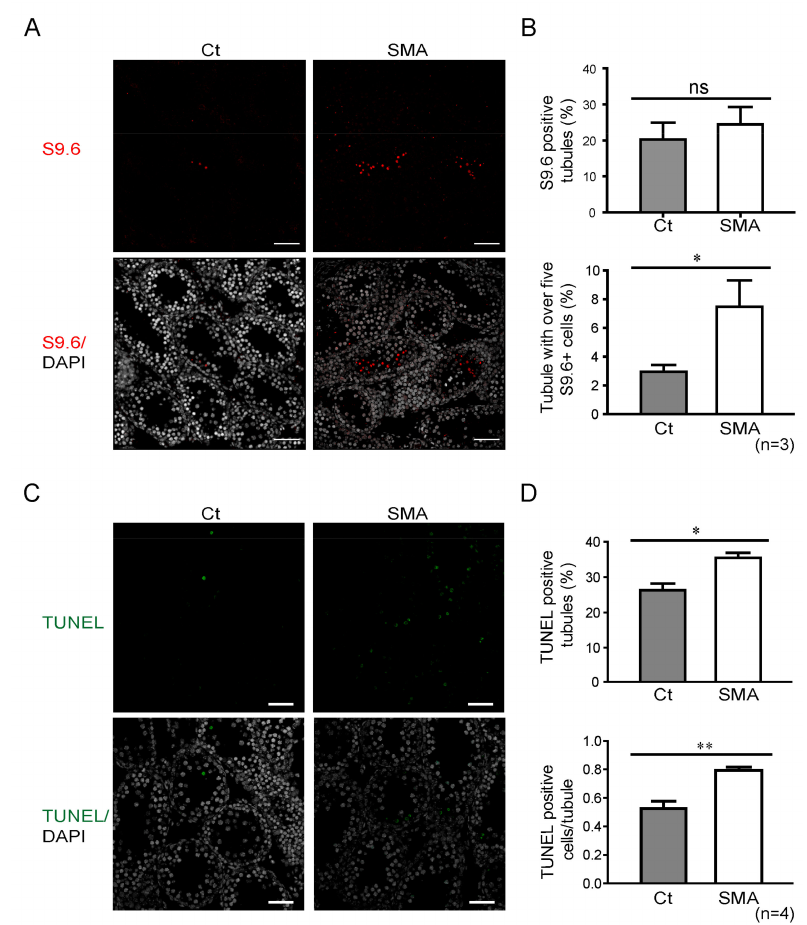
Figure 4. Detection of RNA:DNA hybrid structure in SMA-like mice. ( A ) Staining result of the RNA:DNA hybrid structure, R-loop, by the detecting antibody S9.6 (red) and DAPI (white) in SMA-like mice (SMA) and littermate controls (Ct) (scale bar = 50 µ m). ( B ) Upper panel: Percentage of S9.6-positive seminiferous tubule of SMA-like mice (SMA, n = 3) and control littermates (Ct, n = 3 mice per genotype). Lower panel: Quantification of tubules containing over five S9.6-positive cells. ( C ) TUNEL assay of SMA-like mice (SMA) showing a higher amount of positive signal (green). Nuclei were stained with DAPI (white) (scale bar = 50 µ m). ( D ) Percentage of seminiferous tubules with at least one TUNEL-positive cell (upper panel) and average number of TUNEL-positive cells per seminiferous tubule (lower panel). Over 90 tubules / mouse were counted for S9.6 and TUNEL. *Indicates significance, p < 0.05; **, p <